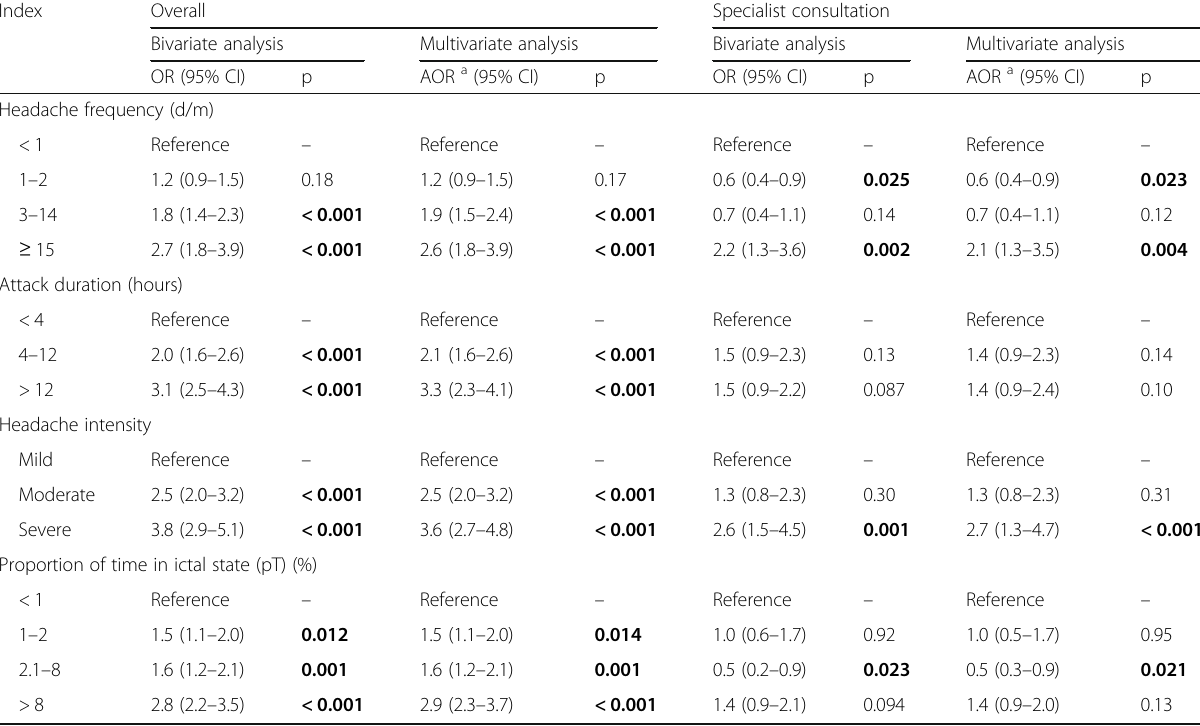
Table 5 Associations between medical consultation and indices of symptom